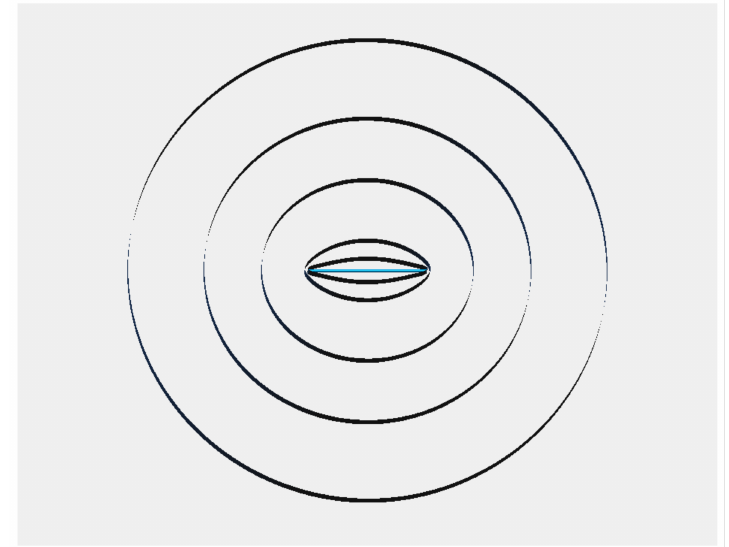
Figure 16. Pressure Iso-line Assumption in Developed Analytical